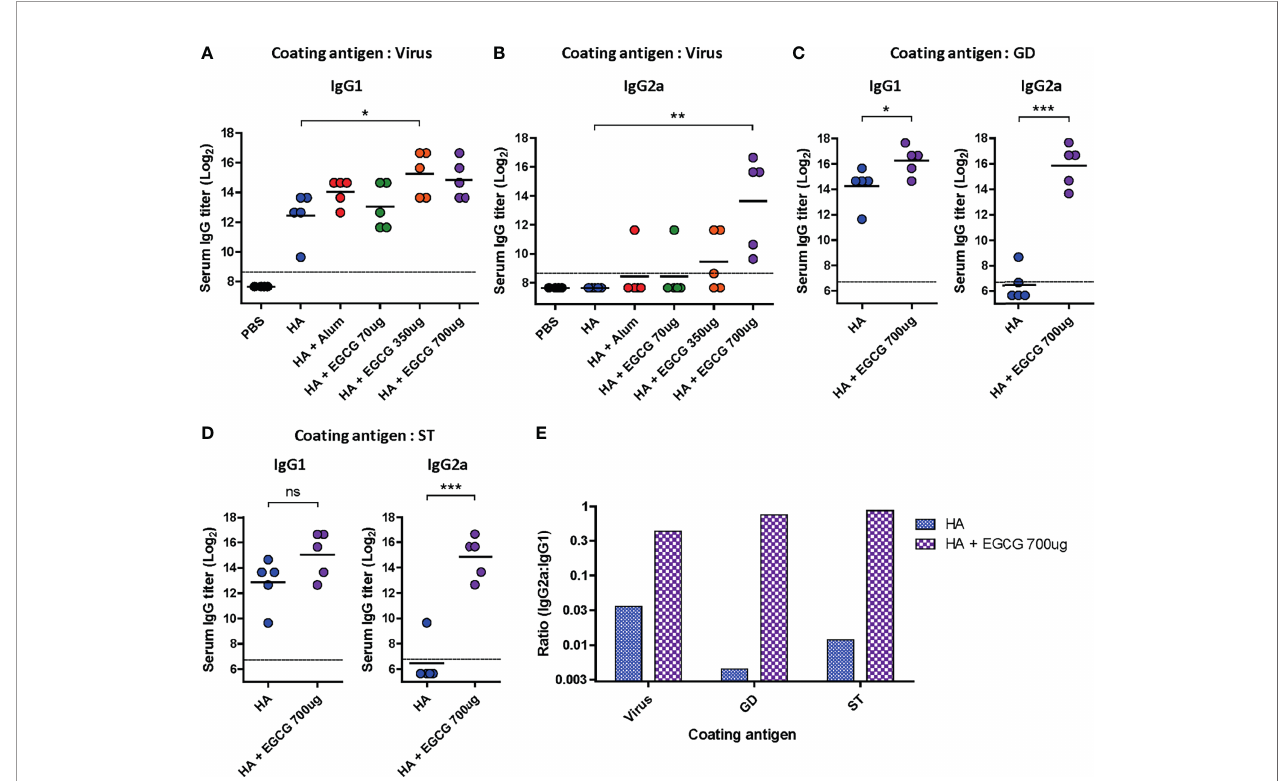
FIGURE 4 | Characterization of serum IgG antibody subclass elicited by EGCG-adjuvanted HA vaccine. PBS or 7 µg of HA antigens with or without adjuvant (30 m L of alum or 70, 350, or 700 m g of EGCG) were injected into mice via IM route thrice every 2 weeks. Sera were collected 2 weeks after the last vaccination. (A, B) IgG1 (A) and IgG2a (B) antibody responses to in fl uenza PR8 virus. The antibody titer of each sample was expressed as the endpoint dilution with an absorbance value 2× greater than that of the PBS control group. Data were log-transformed and expressed as means (horizontal lines) and scatter plots. The detection limits (dashed lines) were 400. (C, D) IgG1 and IgG2a antibody responses to GD (C) or ST (D) of HA protein of in fl uenza PR8 virus. Data were log- transformed and expressed as means (horizontal lines) and scatter plots. The detection limits (dashed lines) were 100. (E) IgG2a/IgG1 ratios of HA and EGCG- adjuvanted HA. The bar graphs indicate geometric means. For convenience, the IgG2a/IgG1 ratios were shown as log scale; corresponding to 12 fold (virus), 190 fold (GD), and 72 fold increase (ST) by EGCG. Student ’ s t -test was used to compare two different groups. One-way ANOVA followed by Tukey ’ s multiple comparison test was conducted to compare three or more groups (*** P < 0.001; ** P < 0.01; * P < 0.05. ns, not signi fi